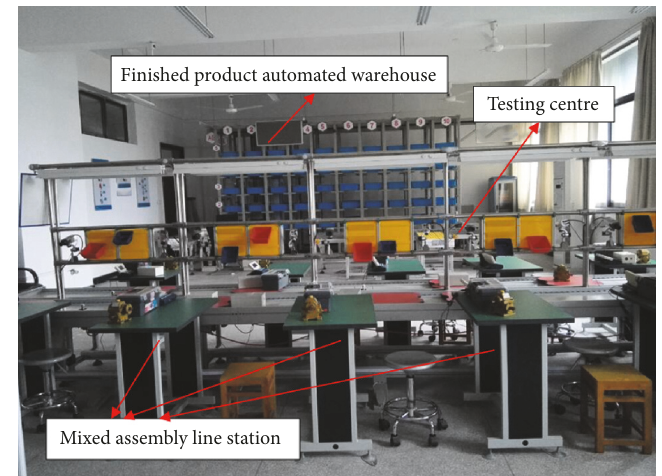
Figure 4: Simulation platform of mixed assembly line for industry 4.0